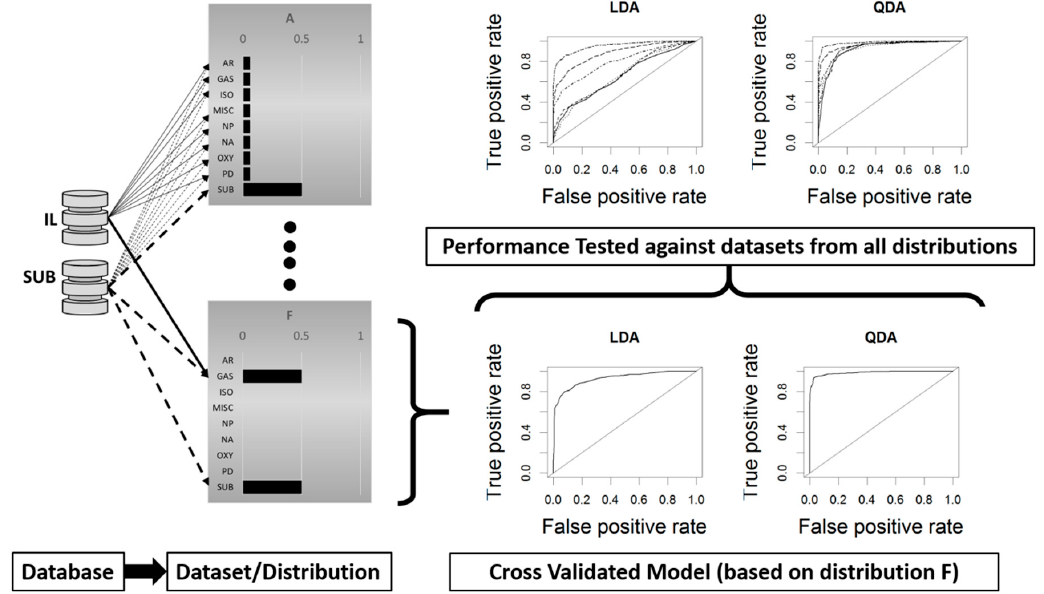
Figure 3. Procedure and results for developing LDA and QDA models based on a dataset having distribution F (Table 1) and testing the model with datasets having distributions A–F (Table 1).